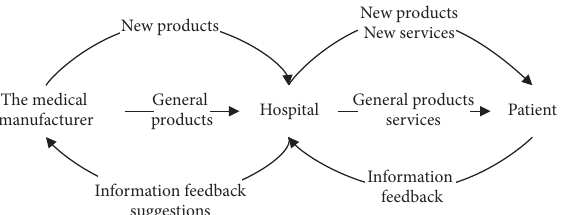
Figure 1: The concept of feedback in the medical supply chain innovation